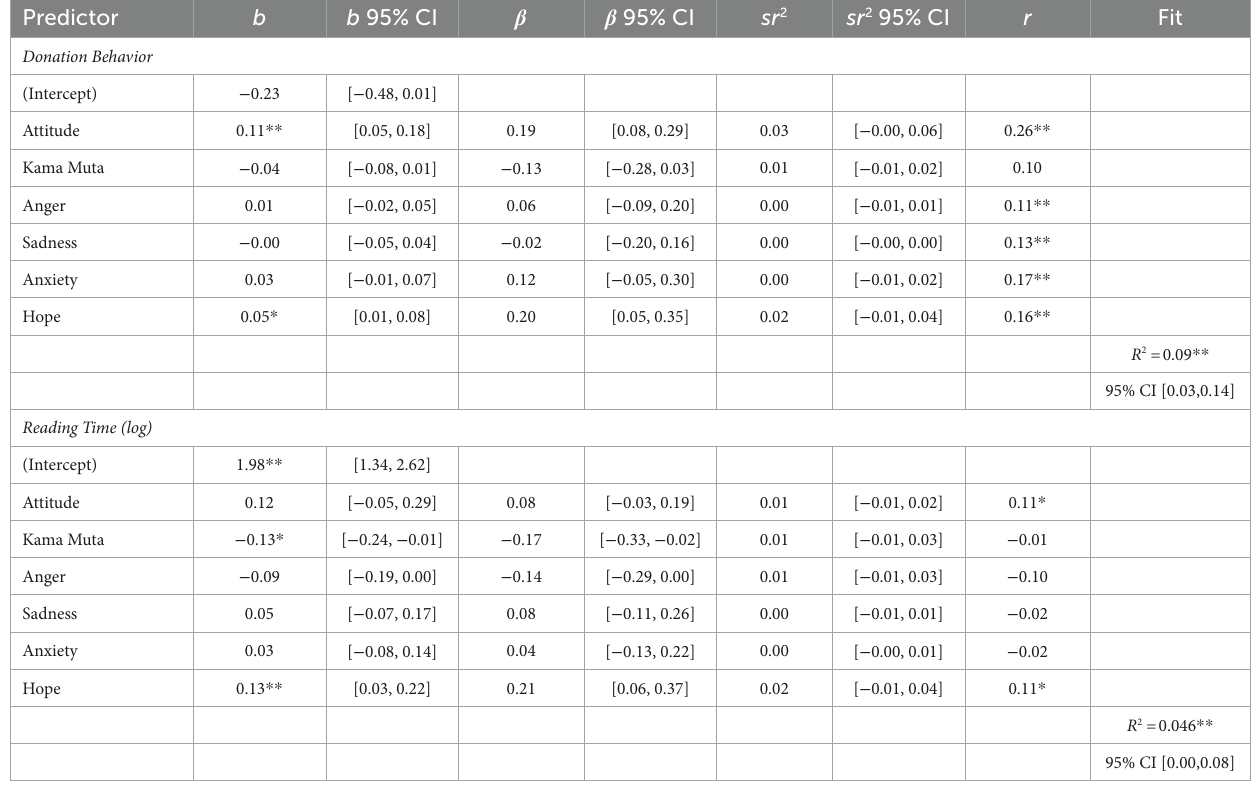
TABLE 5 Regression results using donation behavior (1) and reading time (2) as the criteria in Study 4.